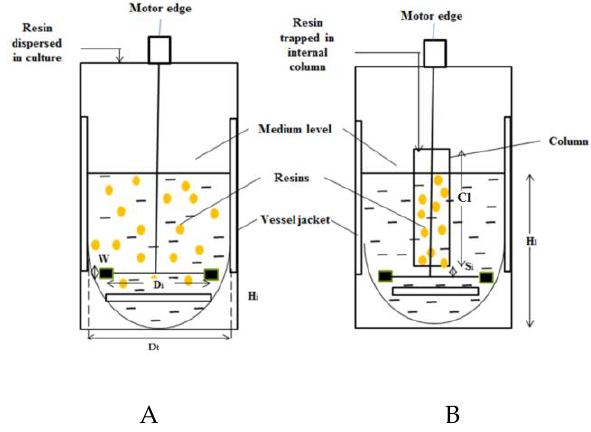
Figure 1. Schematic diagram of the stirred-tank bioreactor ( A ) without and ( B ) with internal column adsorption.